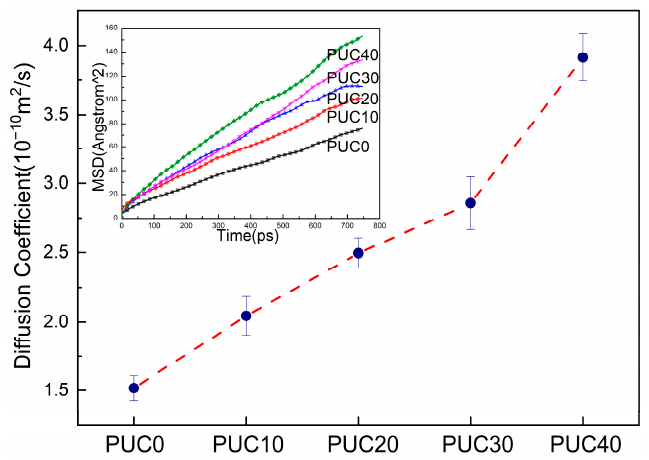
Figure 4. Diffusion coefficients of water in PVA composites with different plasticizer contents and the time dependence of MSD at 368 K. (The MSD curves contained the linear part and the noisy part of the long-term simulation. The previous 750 ps data were selected for a clearer representation.)